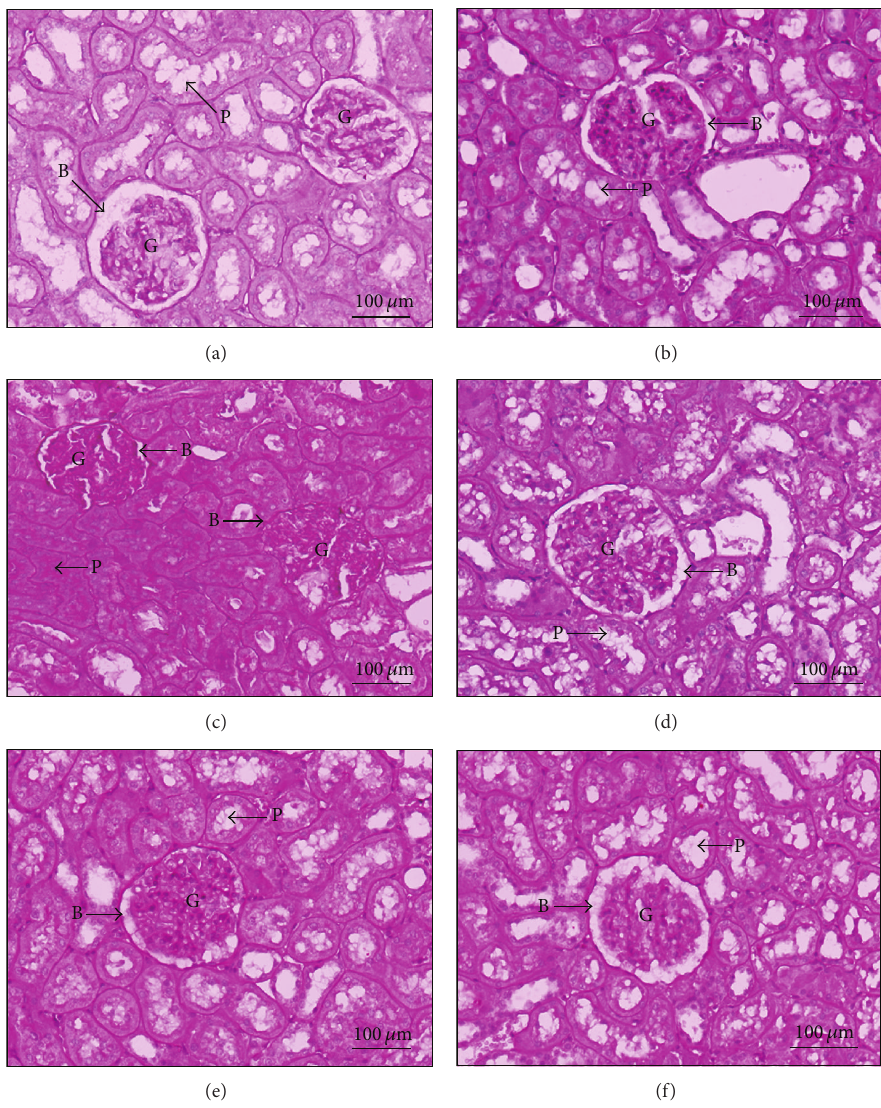
Figure 3: Micrographs of Periodic Acid-Schiff (PAS) staining of rat kidneys. Light microscopies of sagittal half of kidney sections stained with PAS and counterstained with hematoxylin are shown (original magnification 200x for all panels). (a) Normal (ND), (b) normal diet supplemented with CGE (ND + CGE), (c) type 2 diabetes mellitus (DM), and (d) T2DM supplemented with CGE (DM + CGE). Bowman’s capsular spaces are indicated by arrow “B”; the proximal tubular epithelium and the lumen are indicated by arrow “P.” Glomerulus